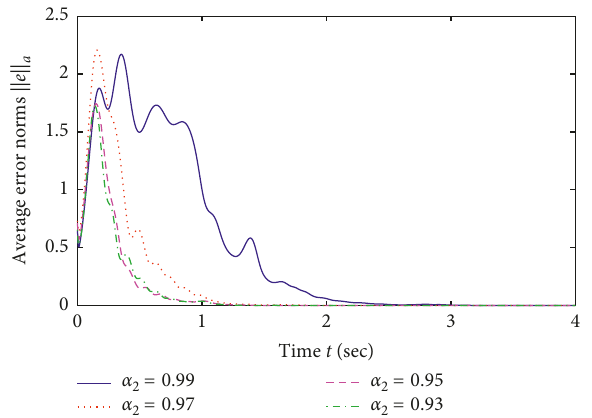
Figure 6: Time evolution of the average error norms || e || different fractional orders α